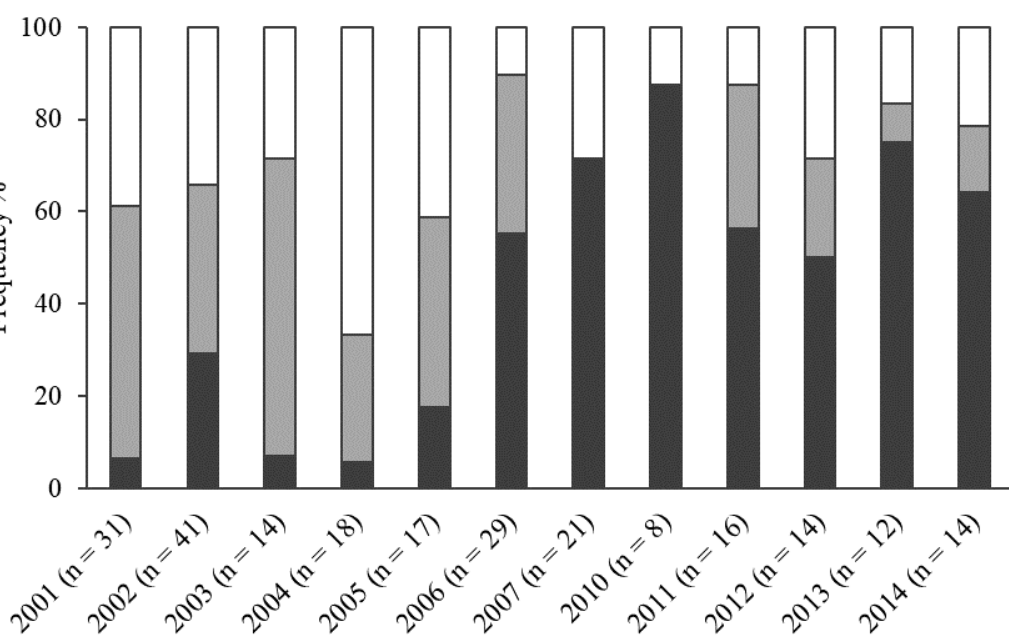
Figure 2. Variation in the percentage of P. infestans isolates with different metalaxyl-sensitivity from potato breeding fields in Estonia during 2001–2007 and 2010–2014. Metalaxyl-sensitivity as: S—sensitive; I—intermediate; and R—resistant. n is the total number of isolates assessed for metalaxyl-sensitivity in each year.